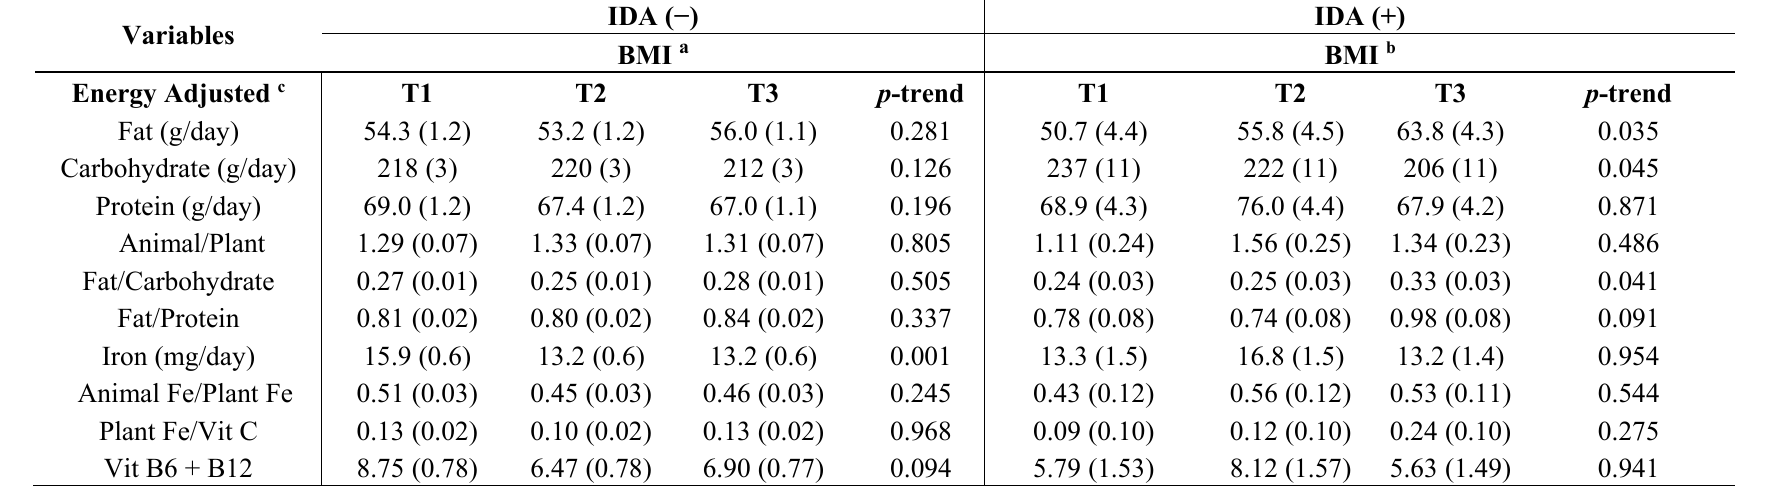
Table 4. Association between dietary intakes, body mass index and iron deficiency anemia ( n = 1274).